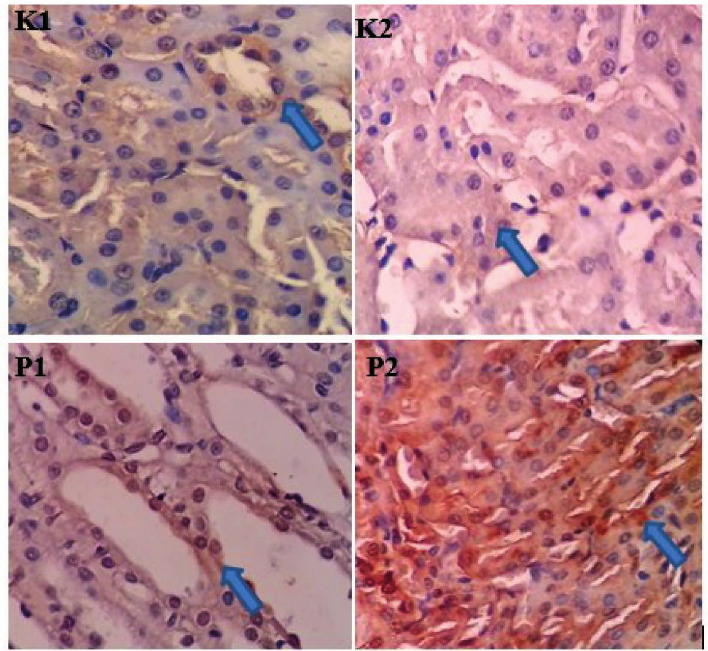
Figure1. Bcl2 expression counts in the renal tubulus of control group and the experimental group, IHC staining, using the Olympus BX Light Microscope at 41 times magnification showed a positive immunostaining expression against